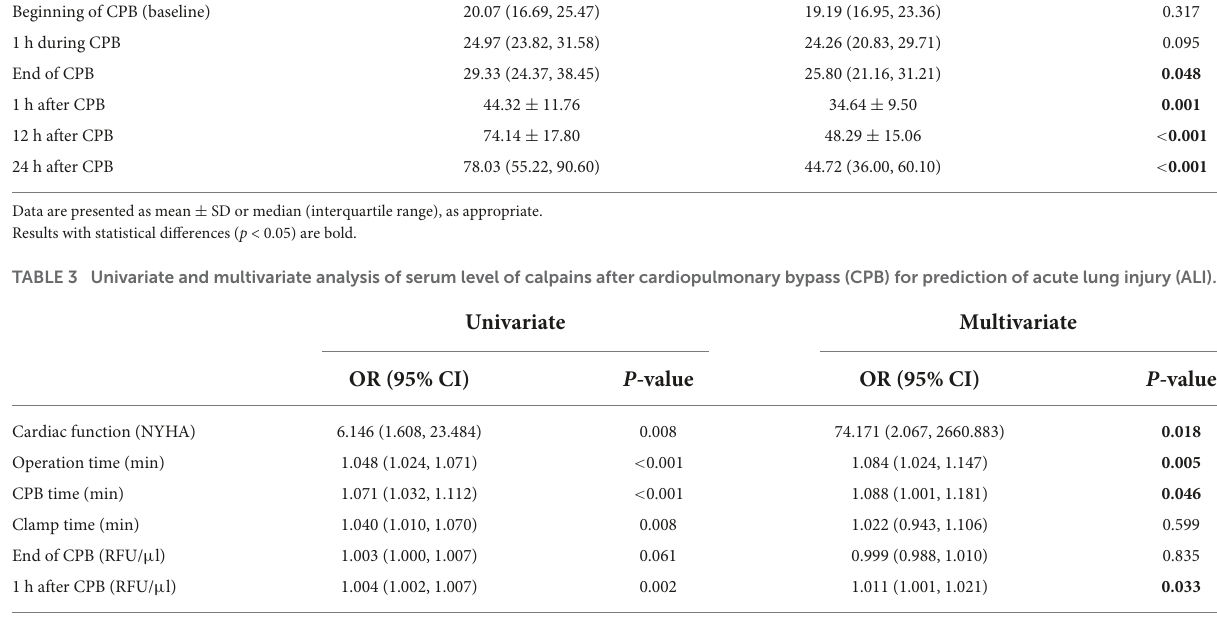
TABLE 2 Serum calpains’ activity relative fluorescence unit (RFU/ µ l) at baseline level and different time points after cardiopulmonary bypass (CPB). Calpains’ activity (RFU/ µ l)